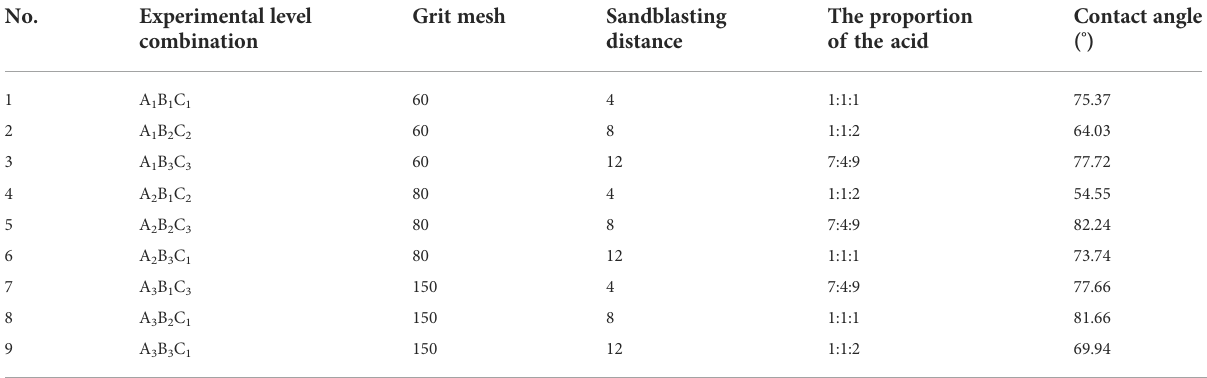
TABLE 2 Experimental level combinations of orthogonal experimental design.